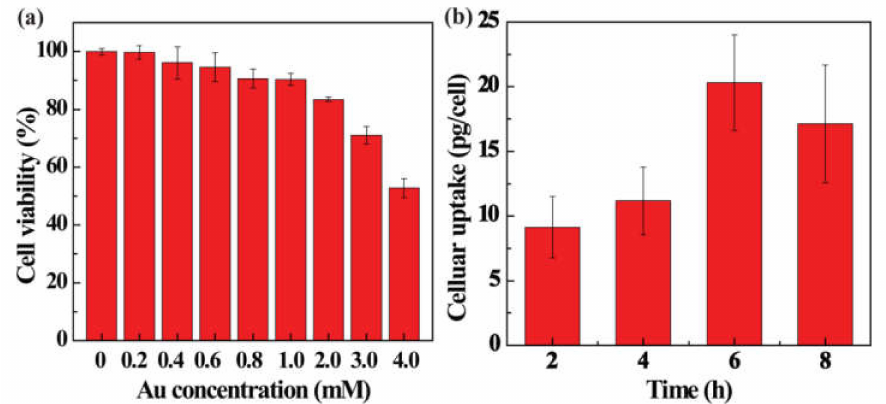
Figure 3. ( a ) Cell viability of Fe 3 O 4 /Au DSNFs cultured with Raw264.7 cells in different Fe concen- tration. ( b ) Cellular uptake of Fe 3 O 4 /Au DSNFs with MAs for 2, 4, 6, and 8 h.